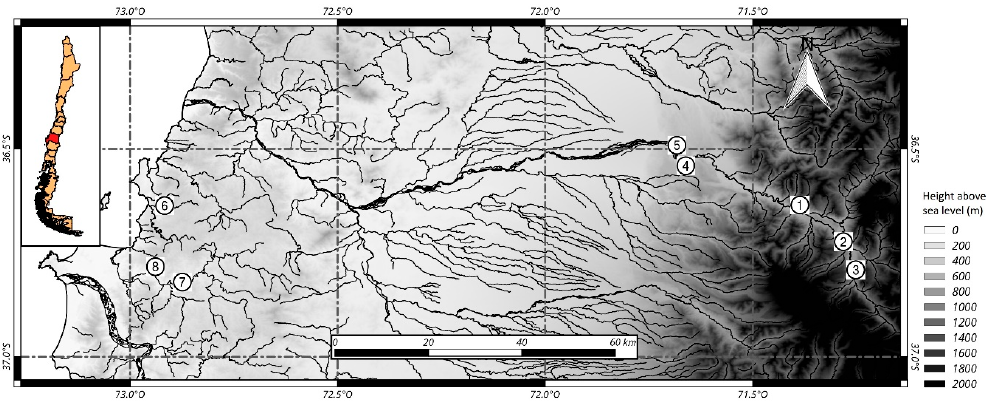
Figure 1. Study area and locations of flow measurements carried out.